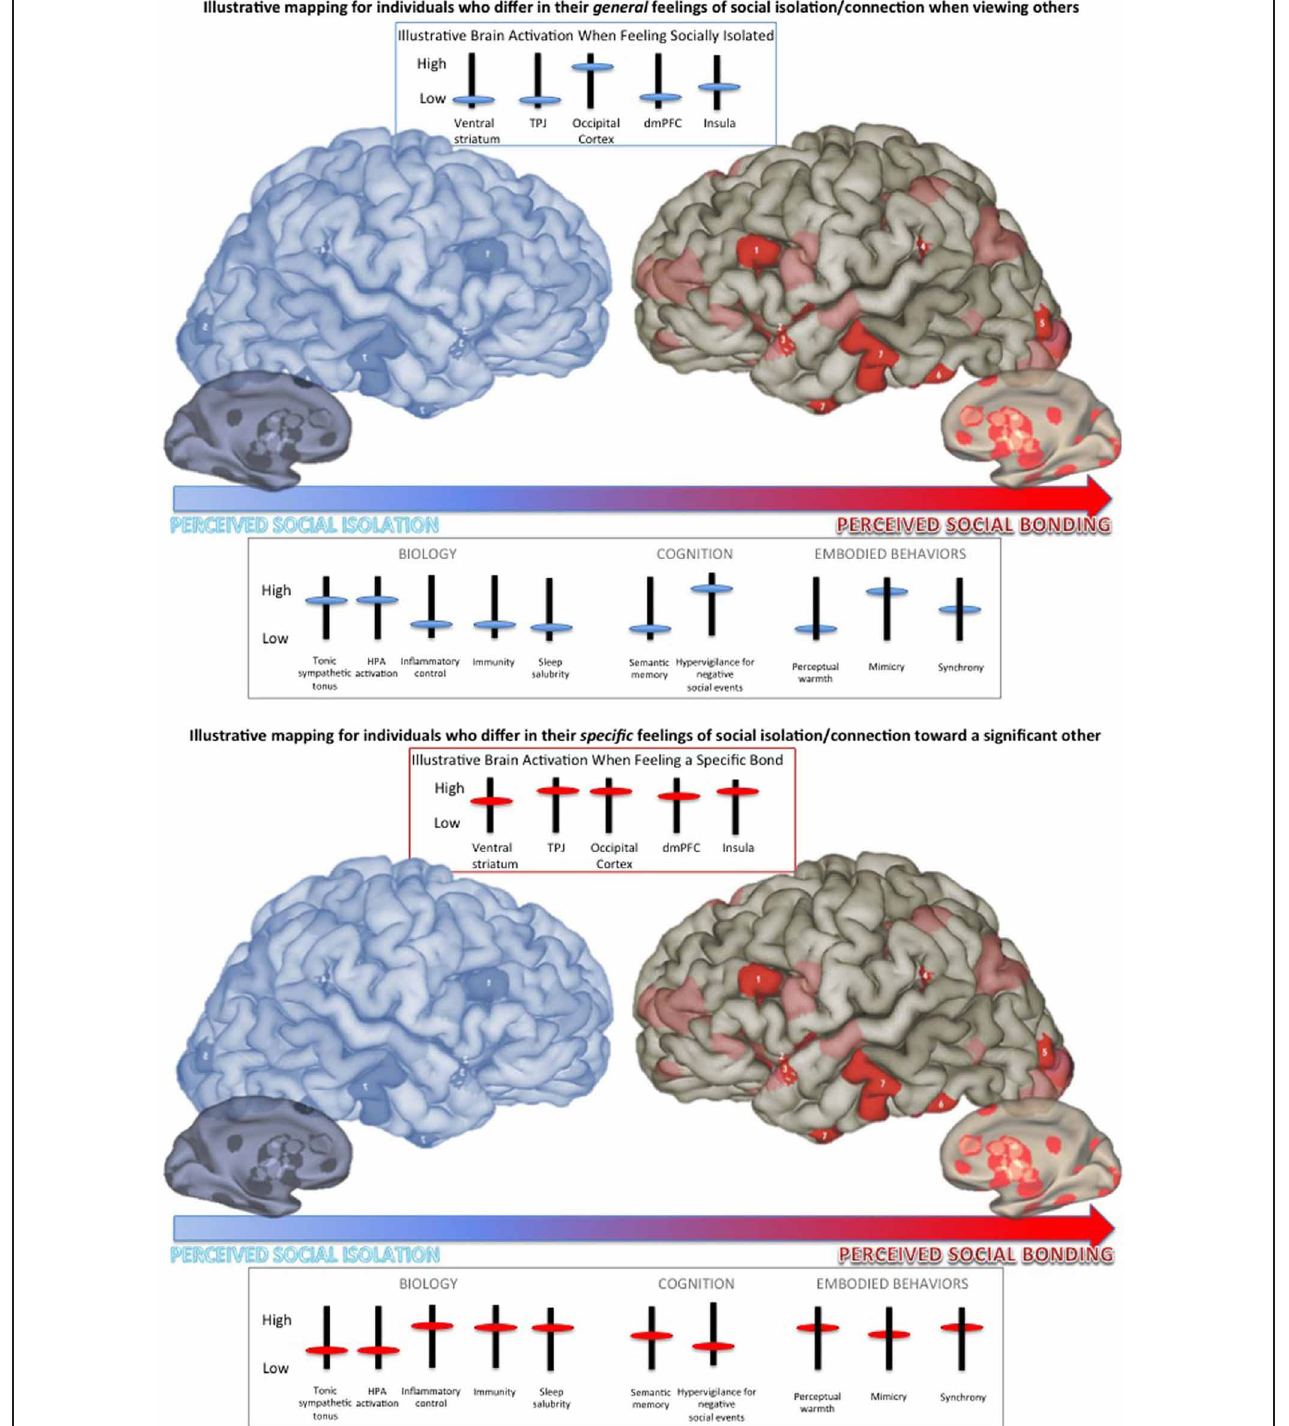
FIGURE 1 | Schematic representation of the continuum of social isolation/bonding from feelings of social isolation or neglect (in blue) to feelings of strong, salubrious social bonds (in red). Brain and behavioral responses differ depending on an individual’s general feeling of social isolation/connection and specific feeling of isolation/connection to the person with whom one is interacting. Top Panel : Illustrative mapping for individuals